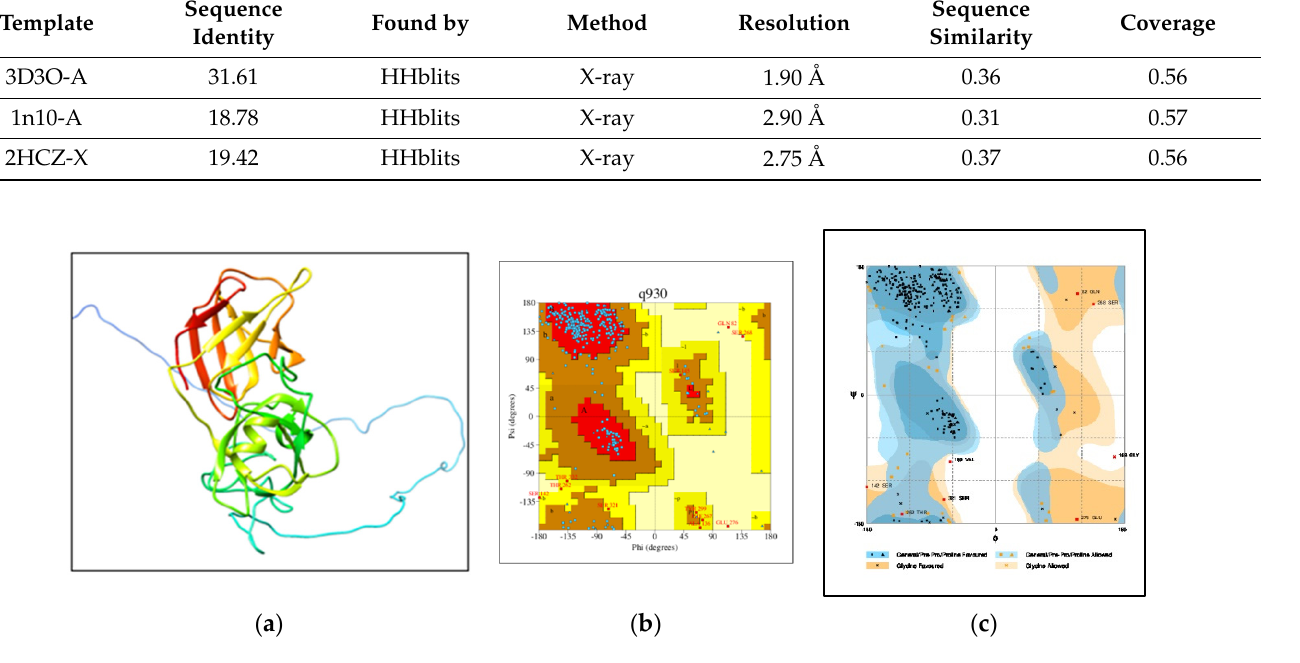
Figure 2. ( a ) Modeled structure of Afu5g08030 ( b , c ) Ramachandran plot of the predicted